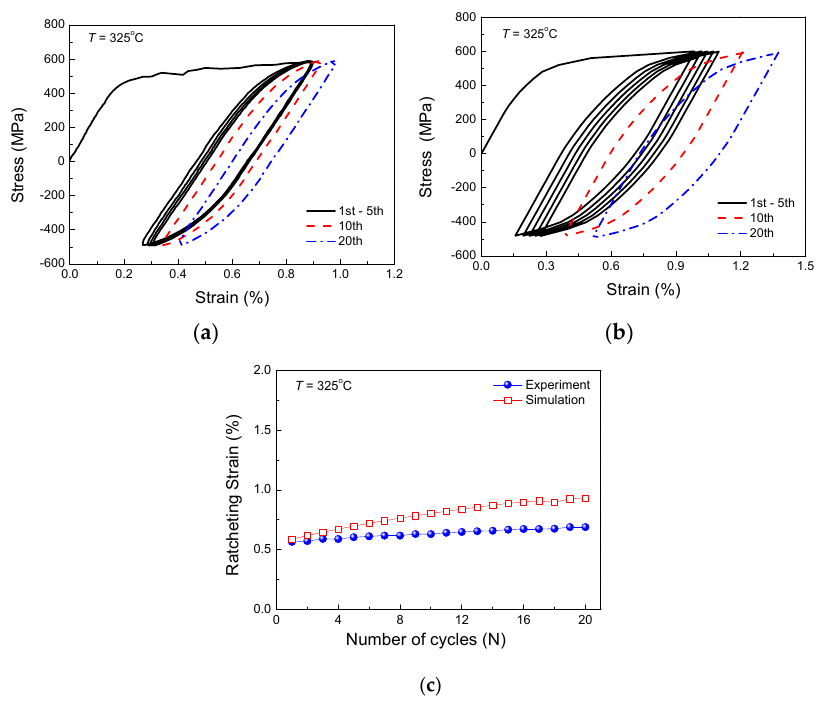
Figure 9. Results of the notched bar at 325 °C: ( a ) experimental stress-strain curves, ( b ) simulated